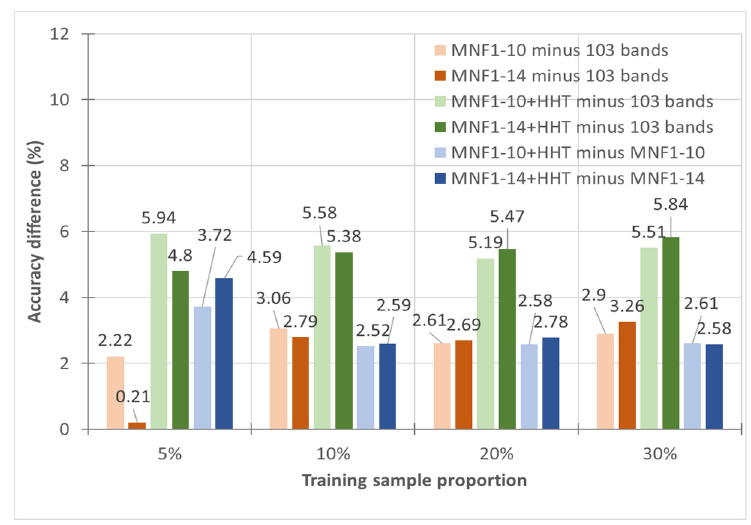
Figure 6. Accuracy comparisons between the original 103 band PaviaU dataset, the MNF-transformed image sets, and the MNF+HHT-transformed image sets.